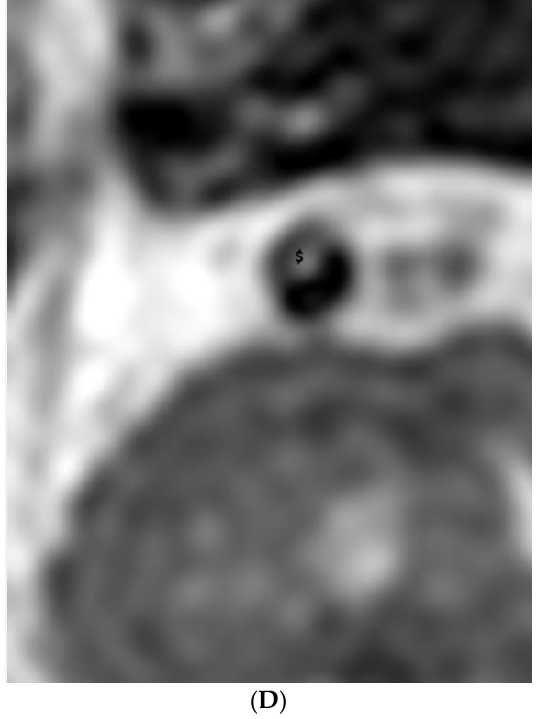
Figure 2. ( A , B ). Dissection. ( A ) Time-of-flight imaging shows a similar high signal intensity between the true lumen and false lumen (#). Note the intimal flap with low signal intensity (white arrow). ( B ) Black blood T2-weighted imaging shows a similar low signal intensity of true and false lumen (#) between the intimal flap (white arrow). ( C , D ). Intraplaque hemorrhage. ( C ) Intraplaque hemorrhage ($) on time-of-flight imaging shows a relatively subtle high signal intensity compared to the high signal intensity of the lumen. Note the fibrous cap with low signal intensity (white arrow). ( D ) Plaque of basilar artery on black blood T2-weighted imaging shows the iso signal intensity compared to the low signal intensity of the lumen.